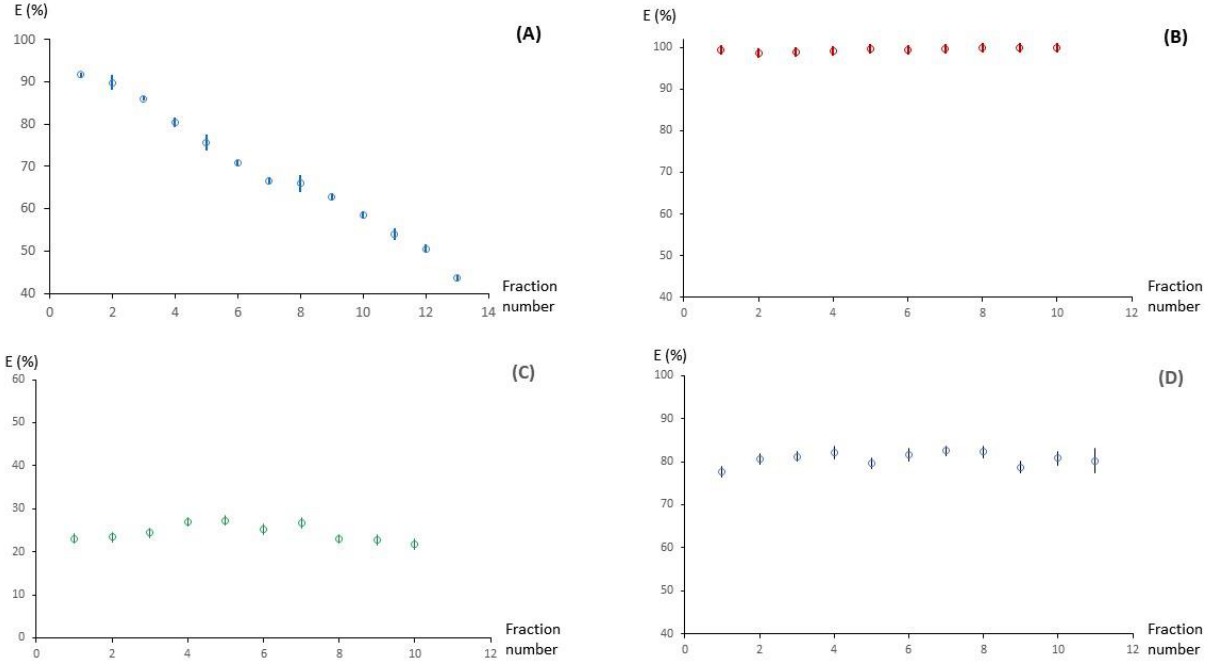
Figure 8. Removal of technetium-99m from wastewater: ( A ) natural form of Tc-99m, ( B ) SnCl 2 added, ( C ) water containing the complexing agents (SnCl 2 reduction), ( D ) hydrazine added.